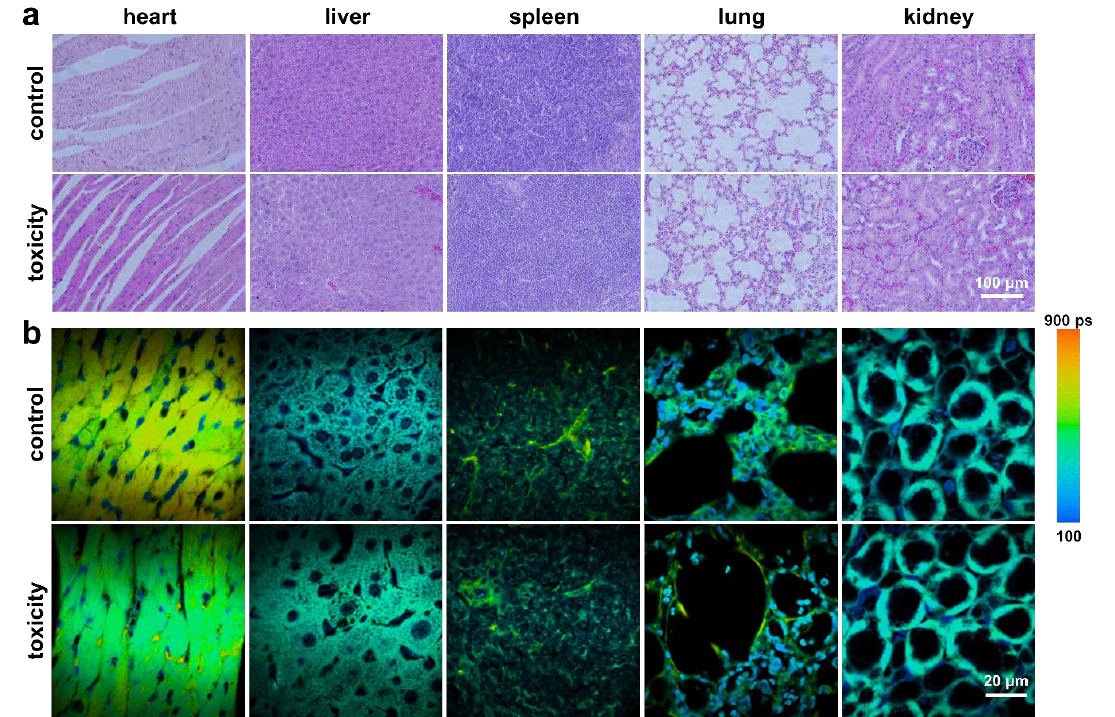
Figure 5. ( a ) Bright field images of tissue slices from five major organs including the heart, liver, spleen, lungs, and kidney after 2 months-post injection. ( b ) Fluorescence lifetime images of tissue slices from five major organs including the heart, liver, spleen, lungs, and kidney after 2 months-post injection. Note that the pseudo-color scale bar in Figure 5b represents the lifetime distribution interval from 100 to 900 ps.